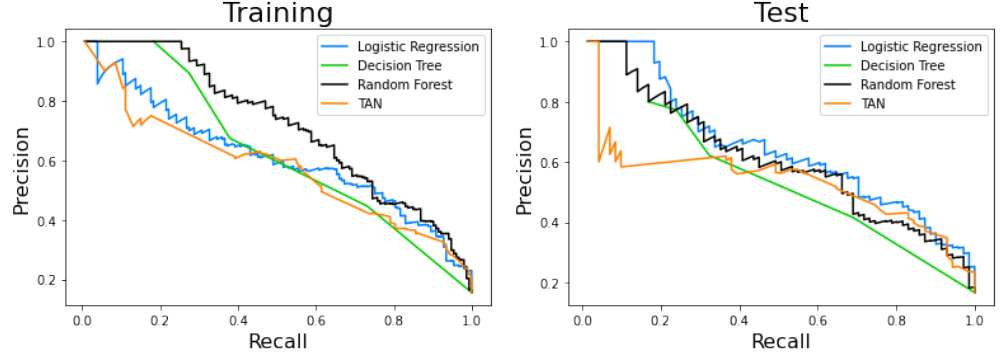
Figure 12. Precision-recall curve of the models. ( Left ) Training set. ( Right ) Testing